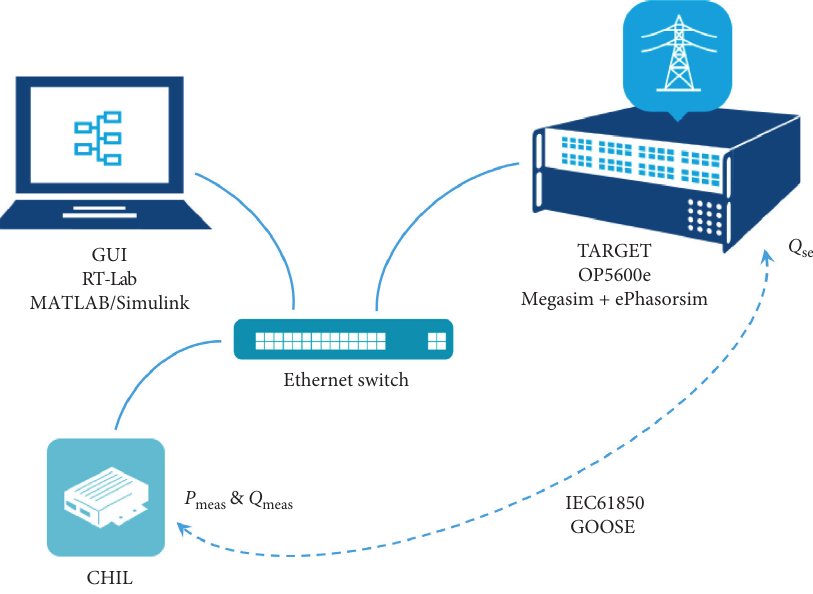
Figure 4: The real-time cosimulation platform [36].